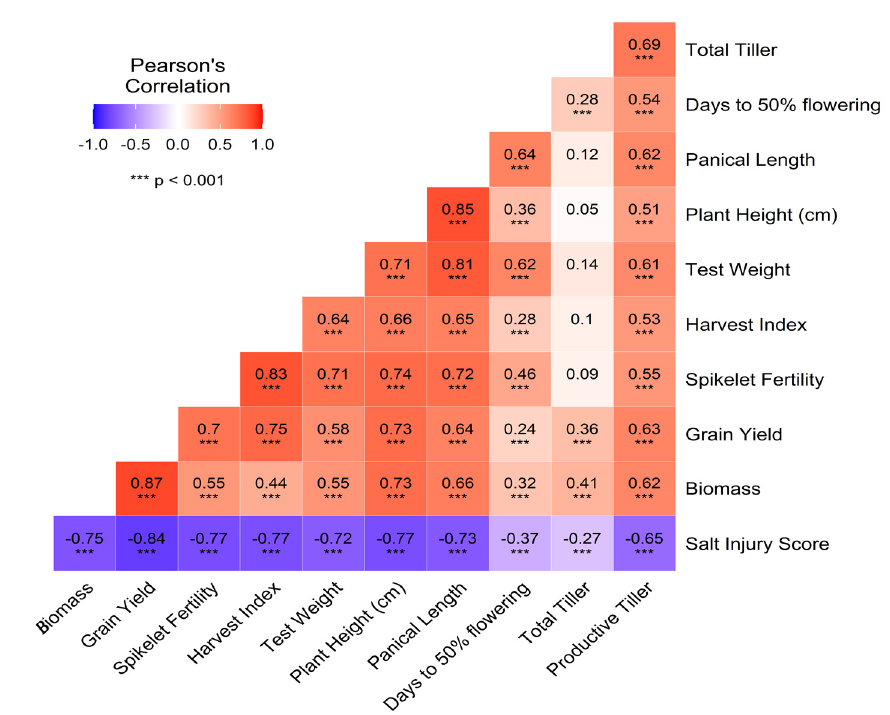
Figure 3. Correlations among morphological traits under alkaline conditions.